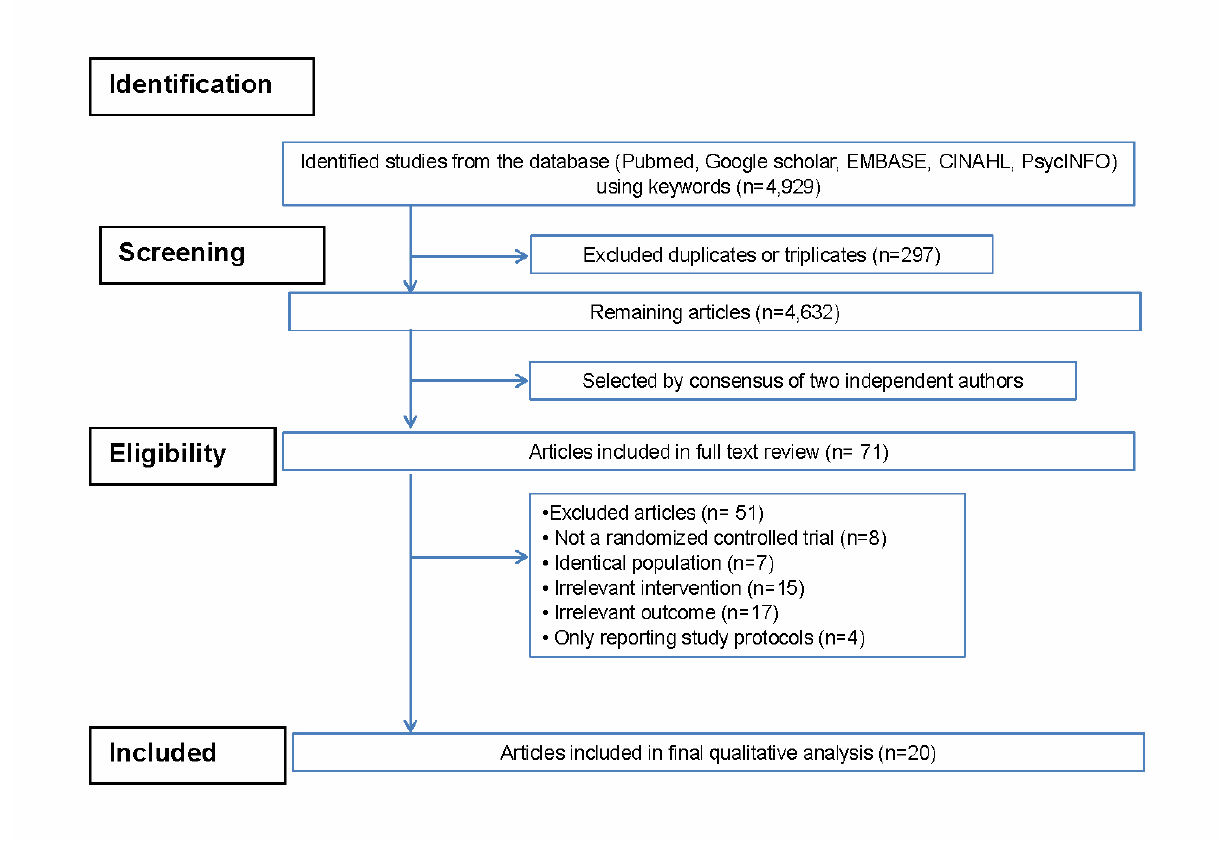
Figure 1. Flow diagram depicting the systematic review